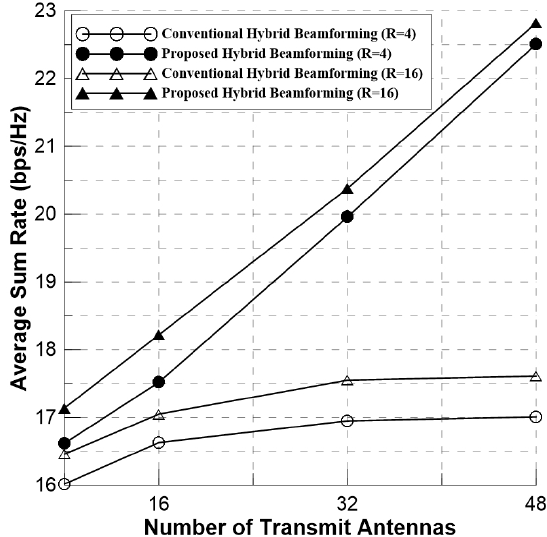
Figure 14. The average sum rate of the hybrid beamforming schemes according to the number of transmit antennas, SNR = 20